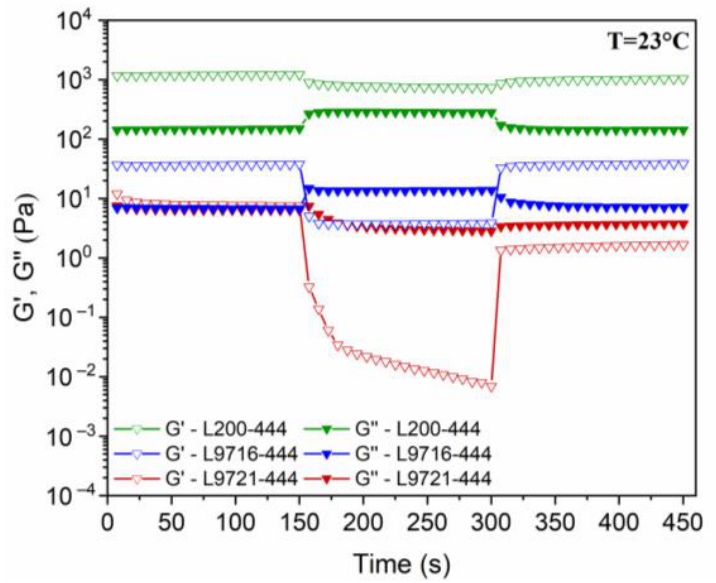
Figure 4. Three-step time test for various binders with black pigment: 1st step: constant low deformation in linear viscoelastic range ( γ = 1%, ω = 1 Hz); 2nd step: constant high deformation in the range of destructive shear conditions ( γ = 100%, ω = 1 Hz); 3rd step: constant low deformation ( γ = 1%, ω = 1 Hz), the same as in 1st step.